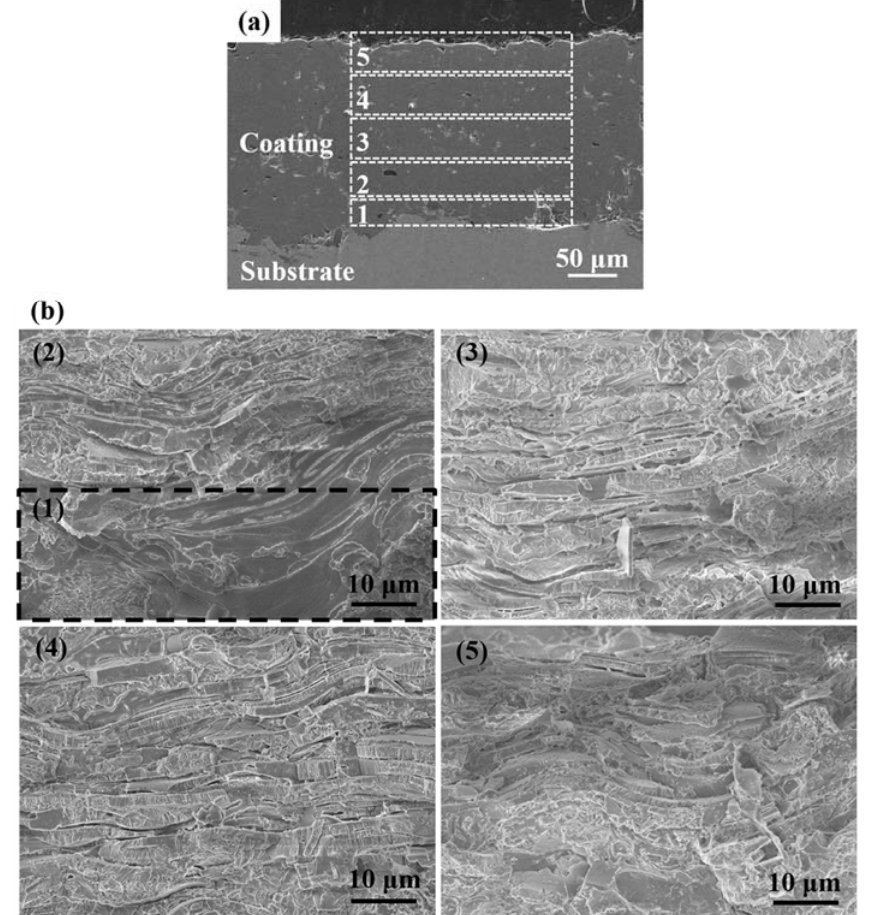
Figure 2. ( a ) Cross ‐ section morphology of the as ‐ sprayed HA coating, and ( b ) SEM morphologies of the chemically etched cross ‐ section of the as ‐ sprayed HA coating.